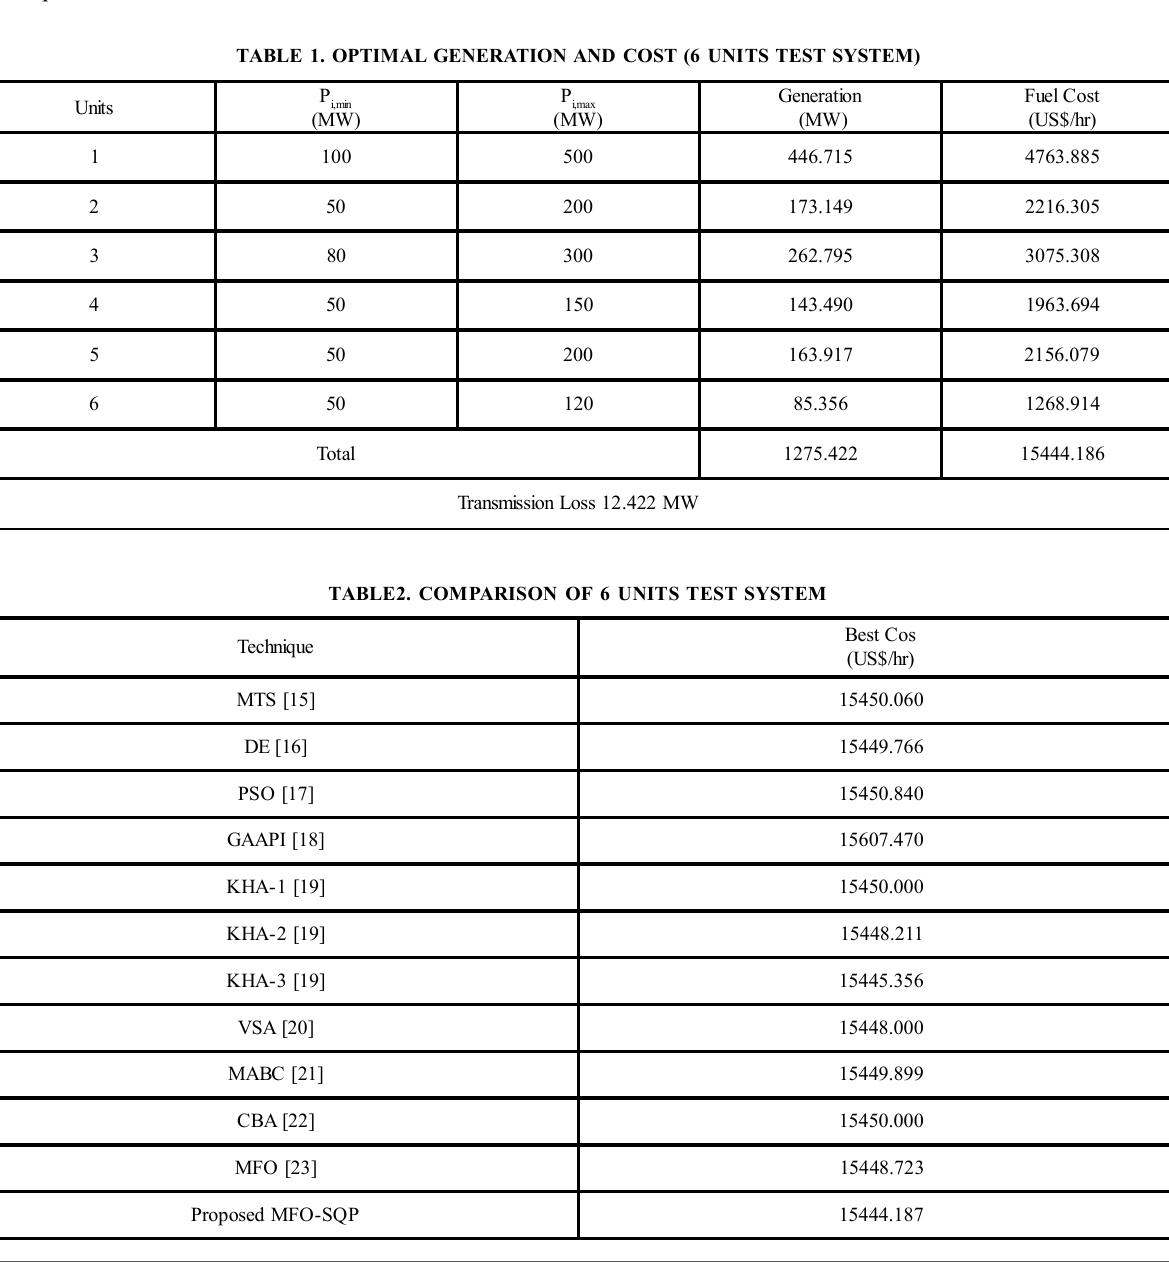
Fig. 1 is showing the convergence characteristics of MFO-